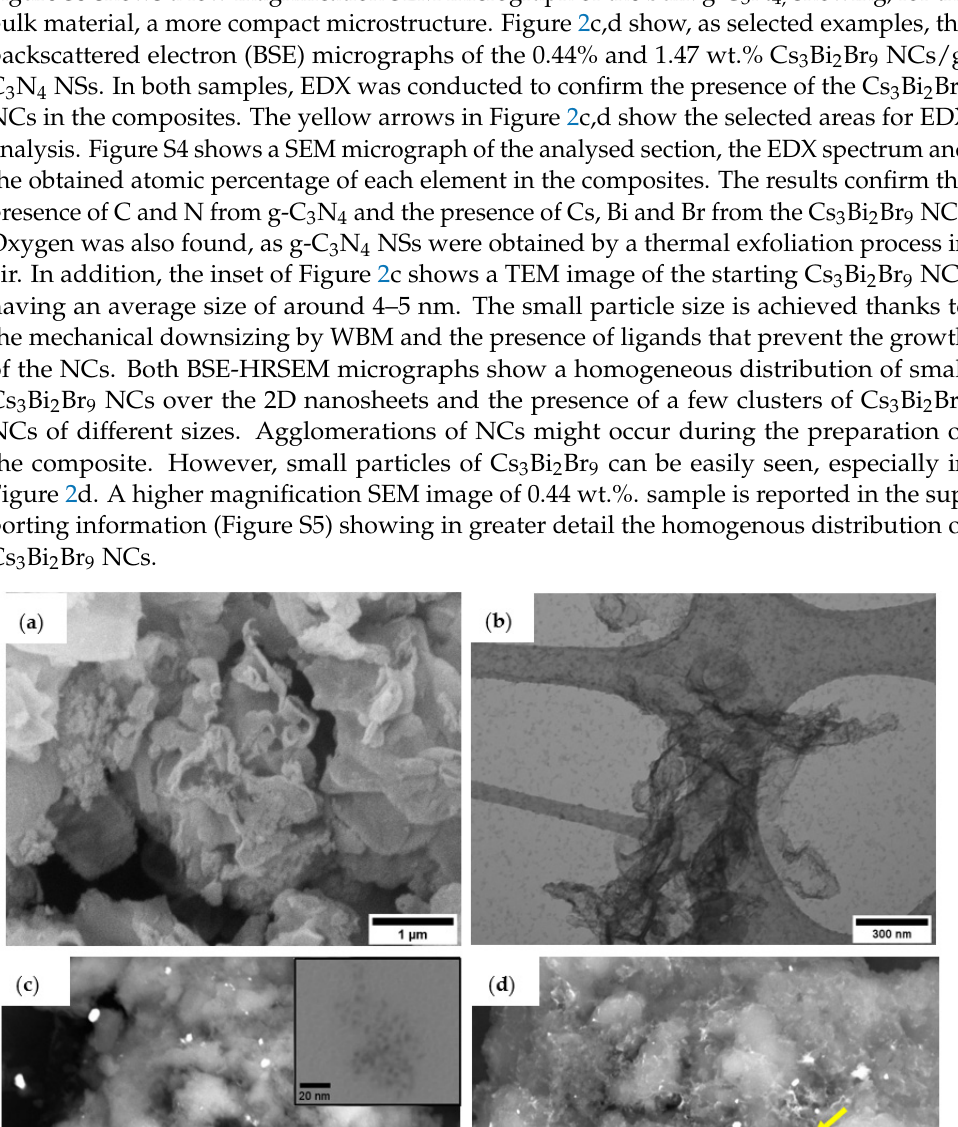
( a ) SEM and ( b ) TEM micrographs of the g-C 3 N 4 NSs, BSE-HRSEM of the ( c ) 0.44 wt.%Cs 3 Bi 2 Br 9 NCs/g-C 3 N 4 NSs, NCs and ( d ) 1.47 wt.%. Cs 3 Bi 2 Br 9 NCs/g-C 3 N 4 NSs. Inset: TEM micrograph of the Cs 3 Bi 2 Br 9 NCs. The yellow arrows show the selected areas for EDX analysis. Optical properties of the Cs 3 Bi 2 Br 9 NCs/g ‐ C 3 N 4 NSs composites were determined by